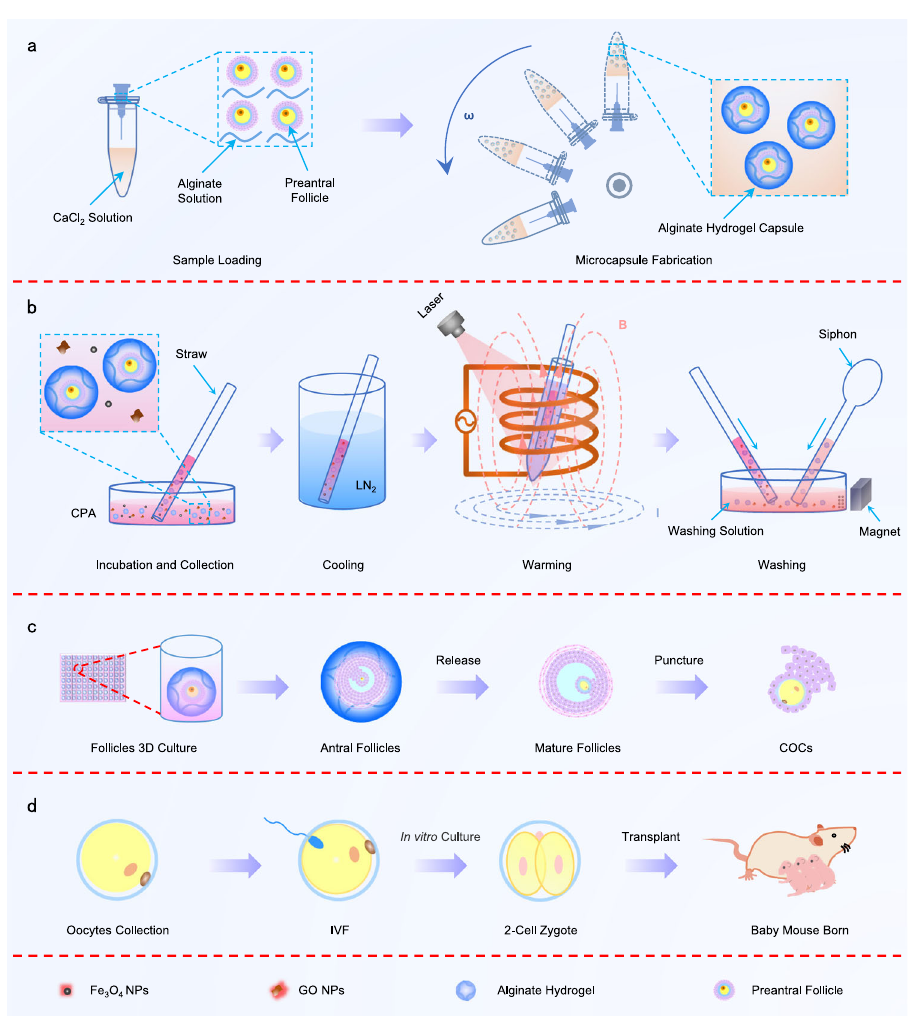
Fig. 1 | Schematic illustration of microencapsulation, cryopreservation, development of preantral follicles (PAFs) in vitro and subsequent in vitro fertilization (IVF) and transplant. a Fabrication of PAF-alginate hydrogel micro- capsules by centrifugal micro fl uidic technology. CaCl 2 solution: 0.15M CaCl 2 solution; Alginate solution: 1% (w/v) alginate solution. b Cryopreservation